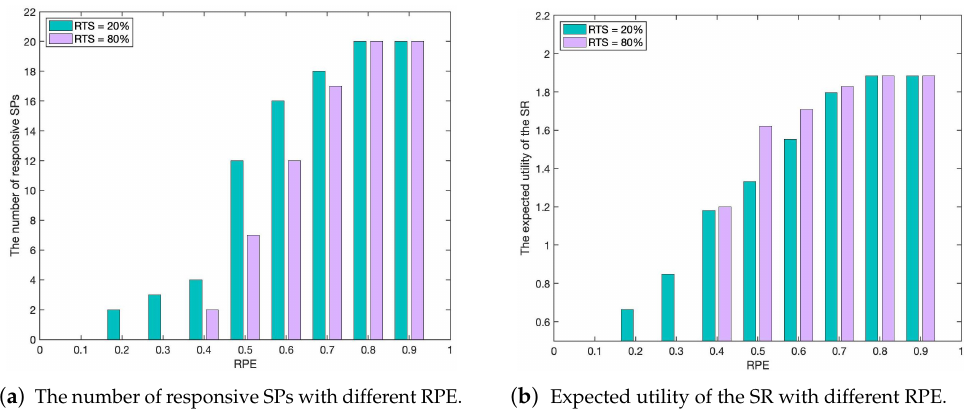
Figure 8. The number of responsive SPs and the SR’s utility with different